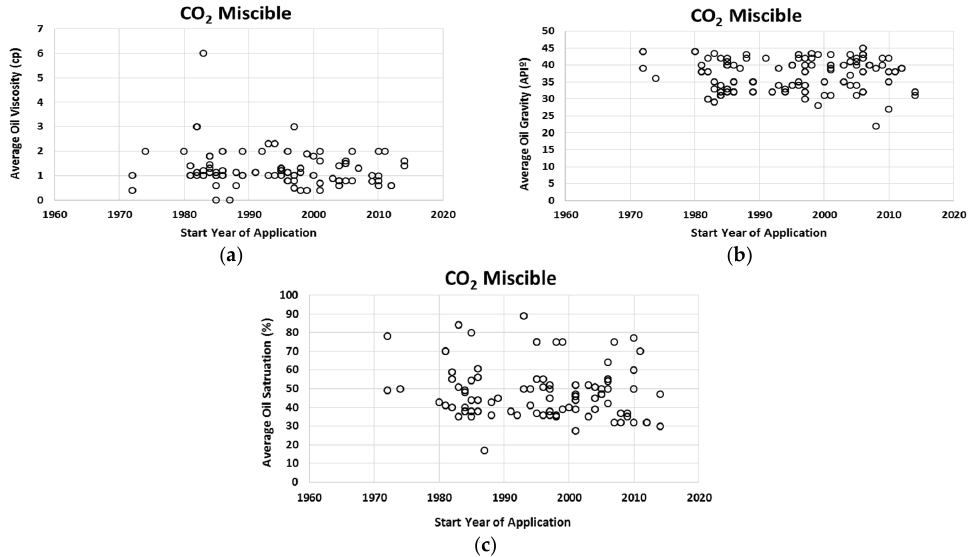
Figure 5. Application data for the CO 2 miscible process by start year of application. ( a ) Oil viscosity; ( b ) Oil gravity; ( c ) Oil saturation.